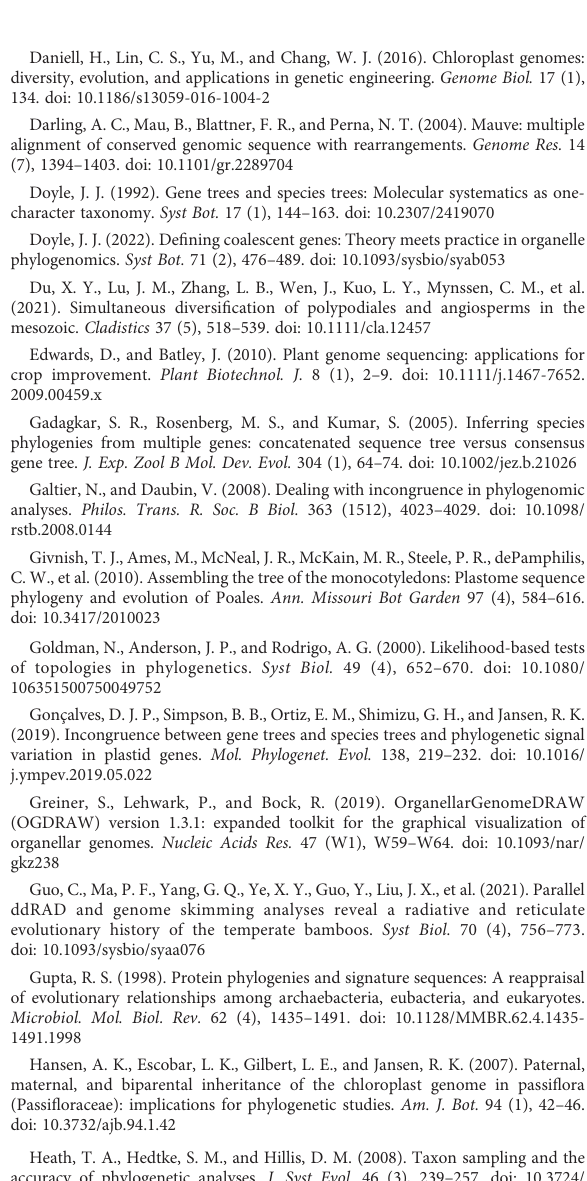
SUPPLEMENTARY TABLE 2 List of loci removed in all datasets. SUPPLEMENTARY TABLE 3 Characteristics of all analyzed plastome datasets. SUPPLEMENTARY TABLE 4 Distribution of phylogenetic signal for the three alternative topologies of showing the phylogenetic position of Dennstaedtiaceae based on gene- wise log-likelihood scores ( D GLS) across each dataset. SUPPLEMENTARY TABLE 5 Gene-wisephylogeneticsignalforthethreealternativetopologiesofshowing the phylogenetic position of Dennstaedtiaceae based on all datasets.